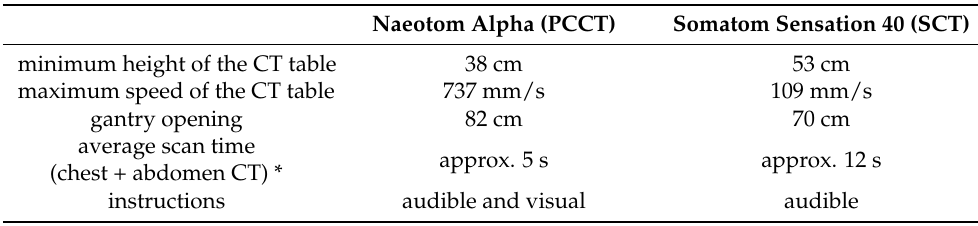
Table 1. Structural properties of both CT scanners that were used in this study. * patient height 175–185 cm, single contrast